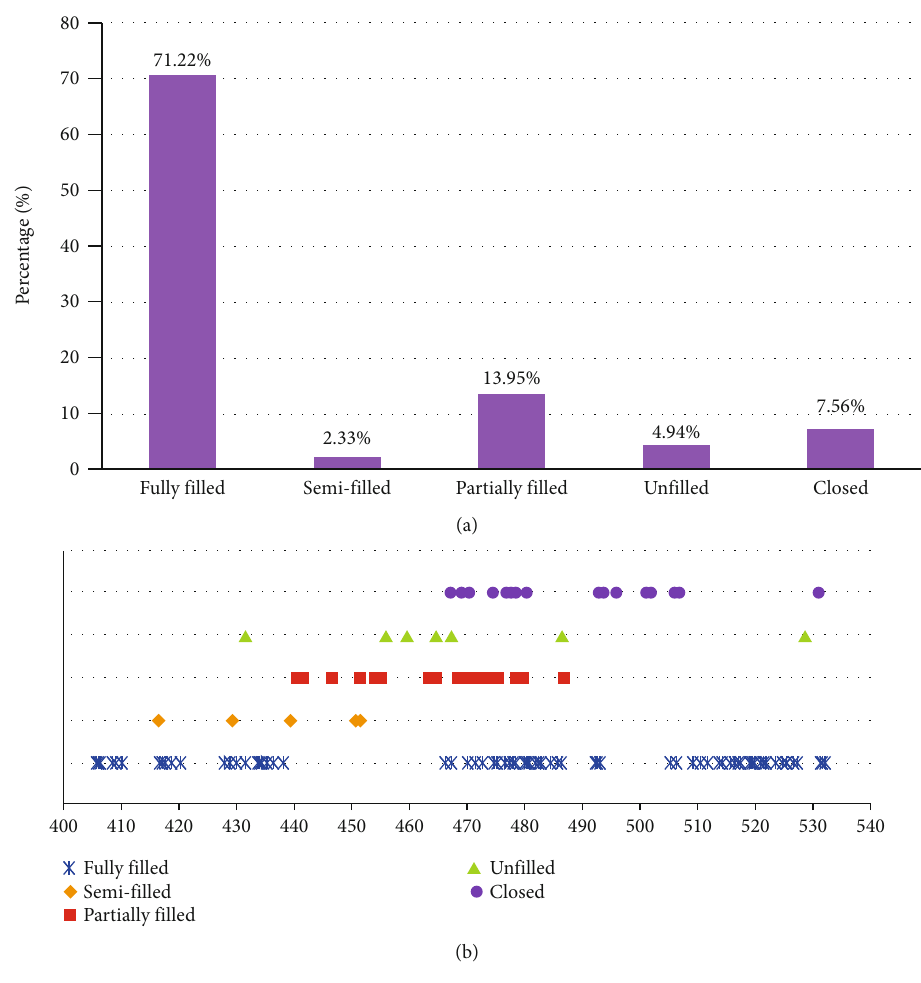
Figure 6: Statistics of fracture fi lling in the target layer of southeastern